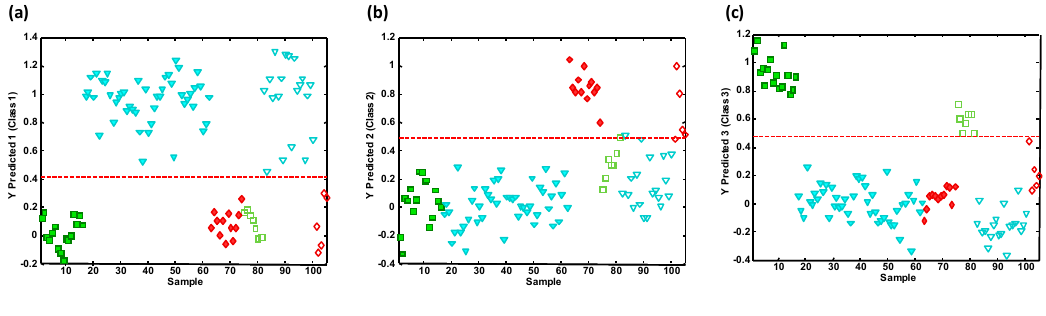
Figure 4. PLS-DA classification plots according to the paprika production region. ( a ) La Vera PDO vs. other classes; ( b ) Murcia PDO vs. other classes; ( c ) Czech Republic vs. other classes. Sample assignment: triangle = La Vera PDO, rhombus = Murcia PDO, square = Czech Republic. Filled symbols = calibration set, empty symbols = validation / prediction set. The dashed line means the classification